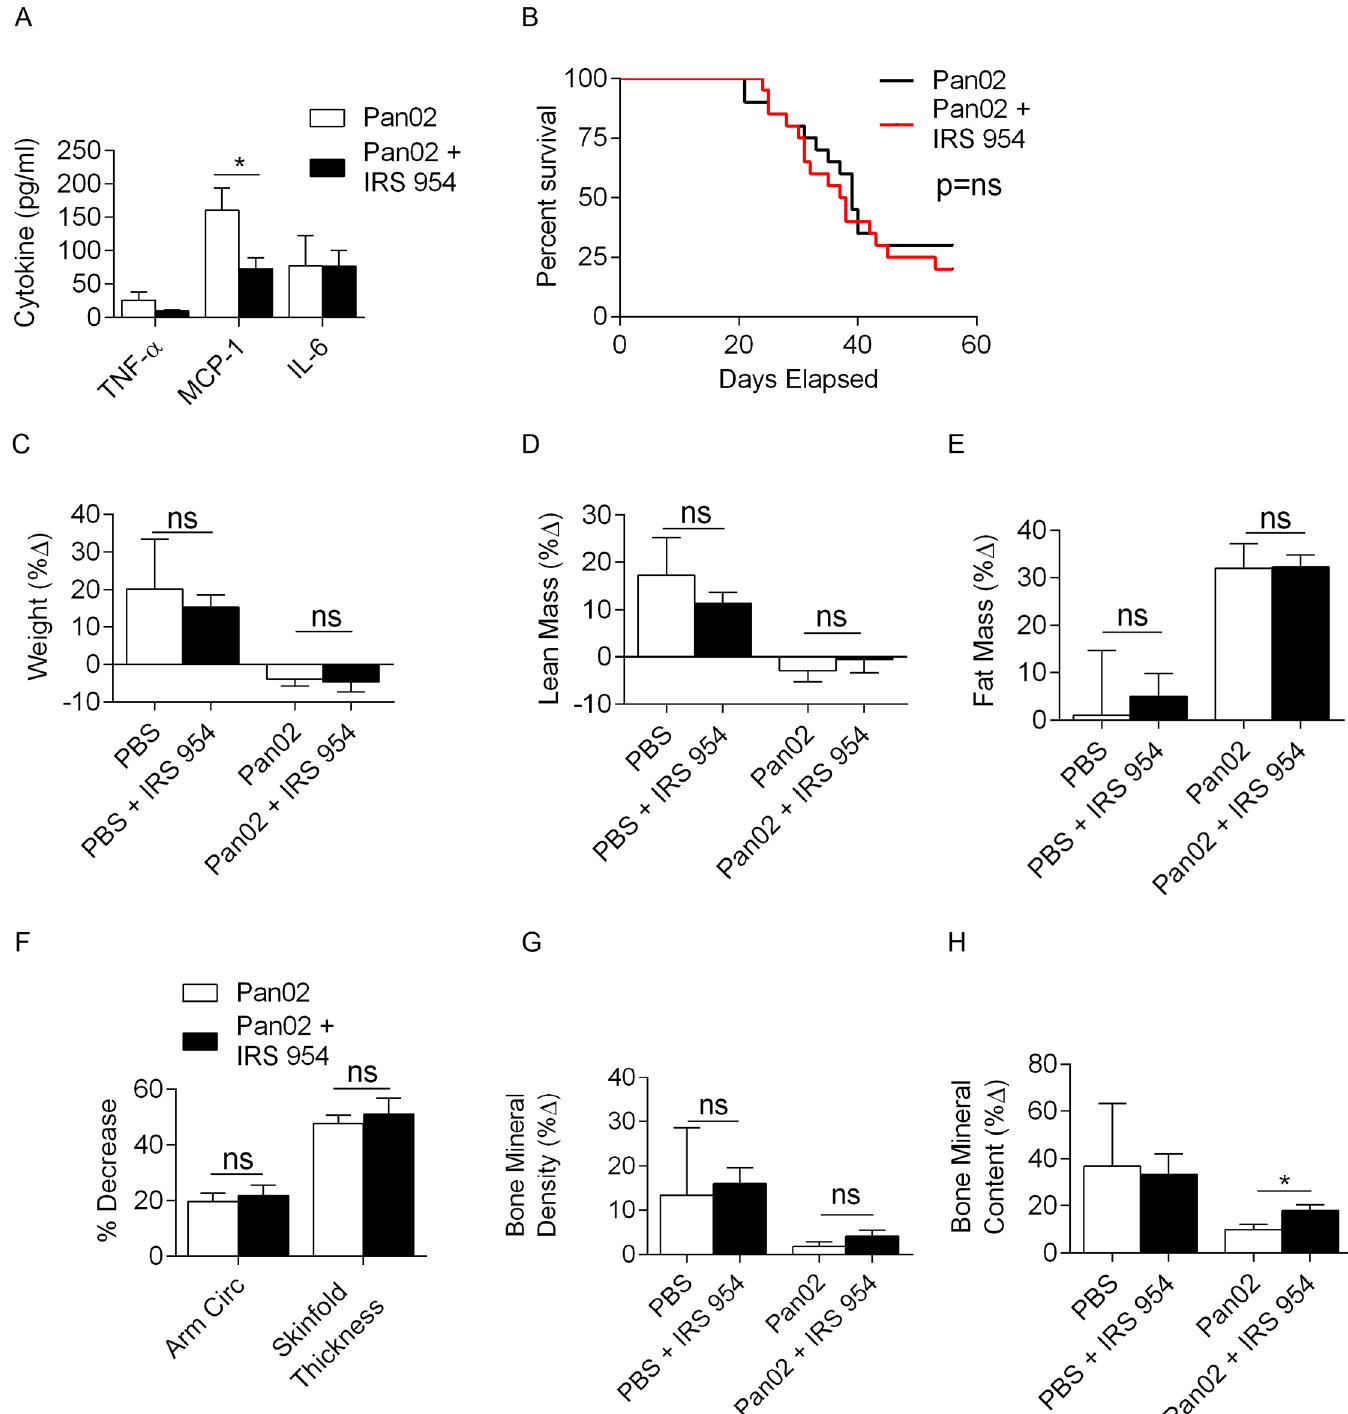
Fig 4. Combined TLR7/9 blockade mitigates inflammation but does not substantially improve the cachectic phenotype. (A) Mice were treated with Pan02 or Pan02 + IRS 954 and tested for serum cytokines (n = 20; * p < 0.05) and (B) survival using the Kaplan-Meier method (n = 20; p = ns). (C) Similarly, mice were treated with PBS, IRS 954, Pan02, or Pan02 + IRS 954 and tested for overall weight change, and changes in (D) lean mass, (E) fat mass, (F) arm circumference and skinfold thickness, (G) bone mineral density, (H) and bone mineral content (n = 20/group; * p < 0.05).